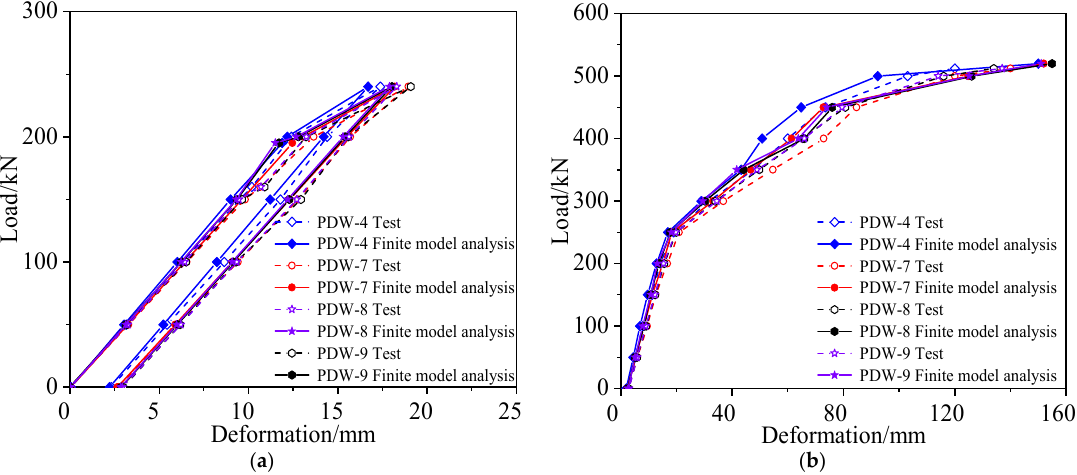
Figure 17. Deformation vs. load of the damaged box girder. ( a ) First cycle of loading and unloading; ( b ) Second loading to failure.